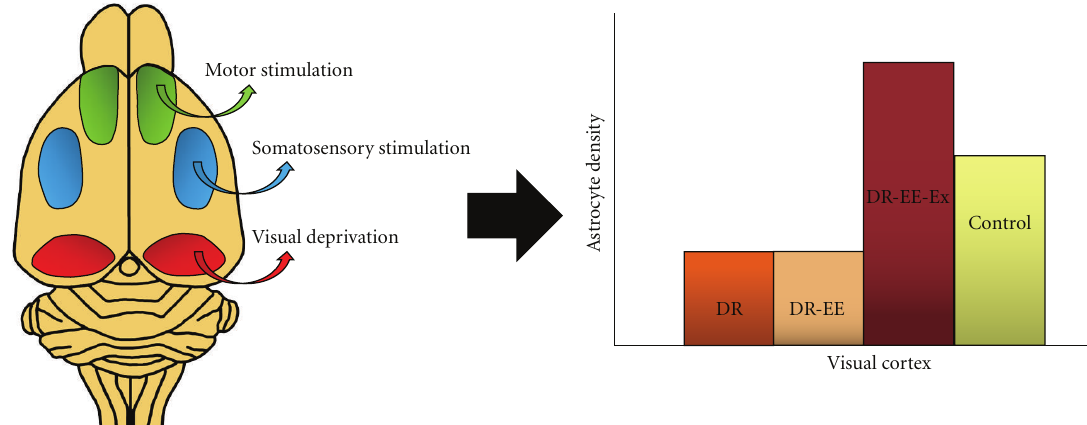
Figure 2: Schematic representation of enriched environment e ff ects on dark-reared rats: motor stimulation, somatosensory stimulation, and visual deprivation caused by dark rearing. We have seen the e ff ects on the astrocyte density of the visual cortex, where enrichment completed with exercise (DR-EE-Ex) can help to recover the loss of population caused by dark rearing (DR), reaching even higher level astrocyte density than the control group. And dark rearing with enriched environment (DR-EE) without running wheel shows similar values to DR group (adapted from results of